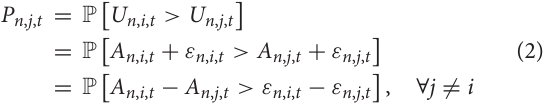
Disease control